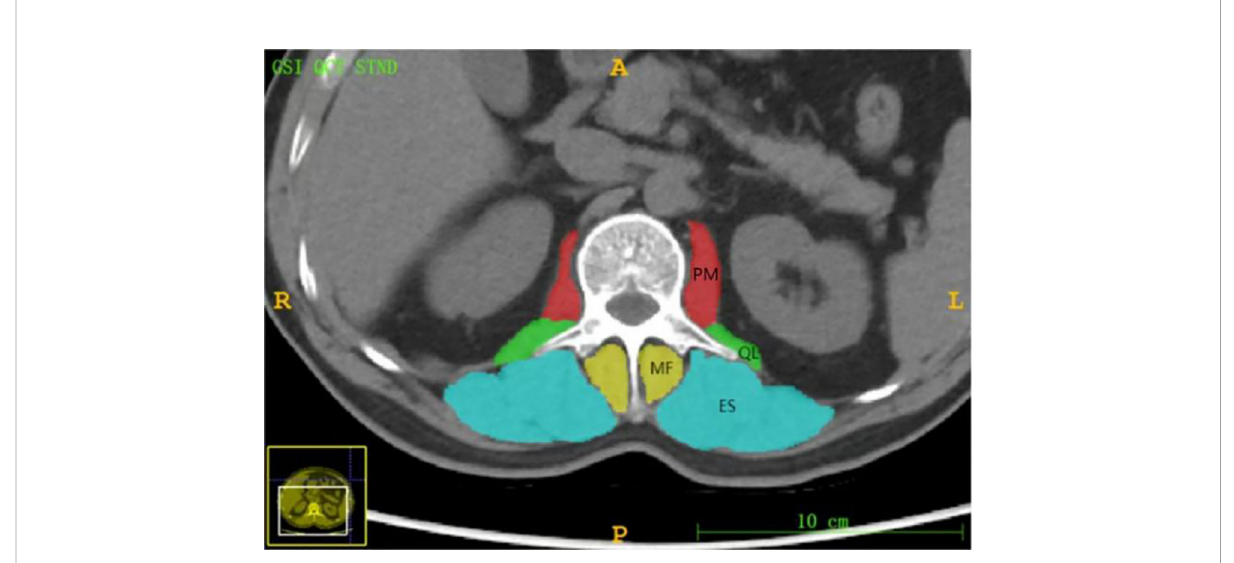
FIGURE 2 Axial level CT image of the L 1 spinous process. The paravertebral muscles (including the psoas major (PM), quadratus psoas (QL), erector spinalis (ES) and multi fi dus (MF)) are outlined as